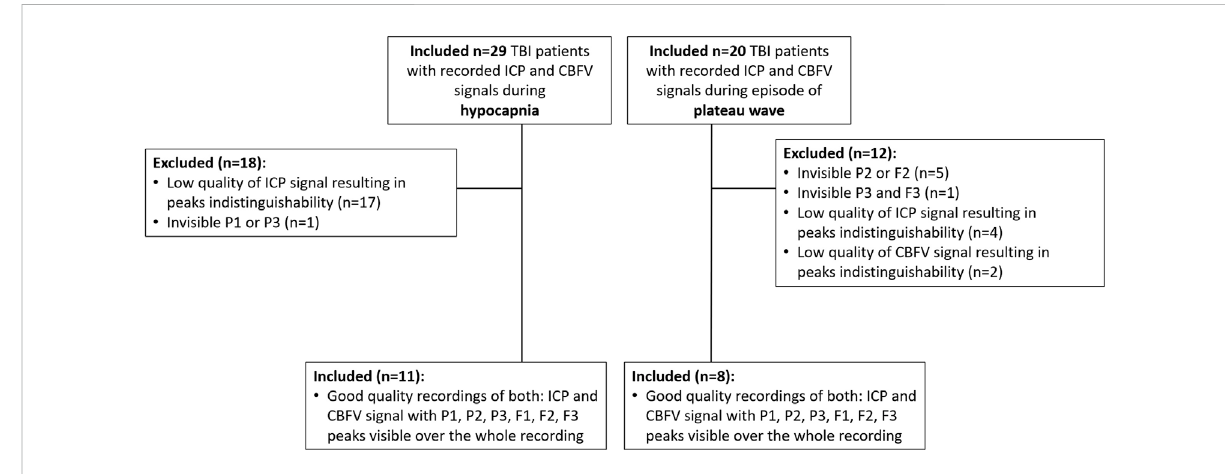
FIGURE 2 Flow diagram of the exclusion process performed to select viable signals with a recorded period of hypocapnia or ICP plateau